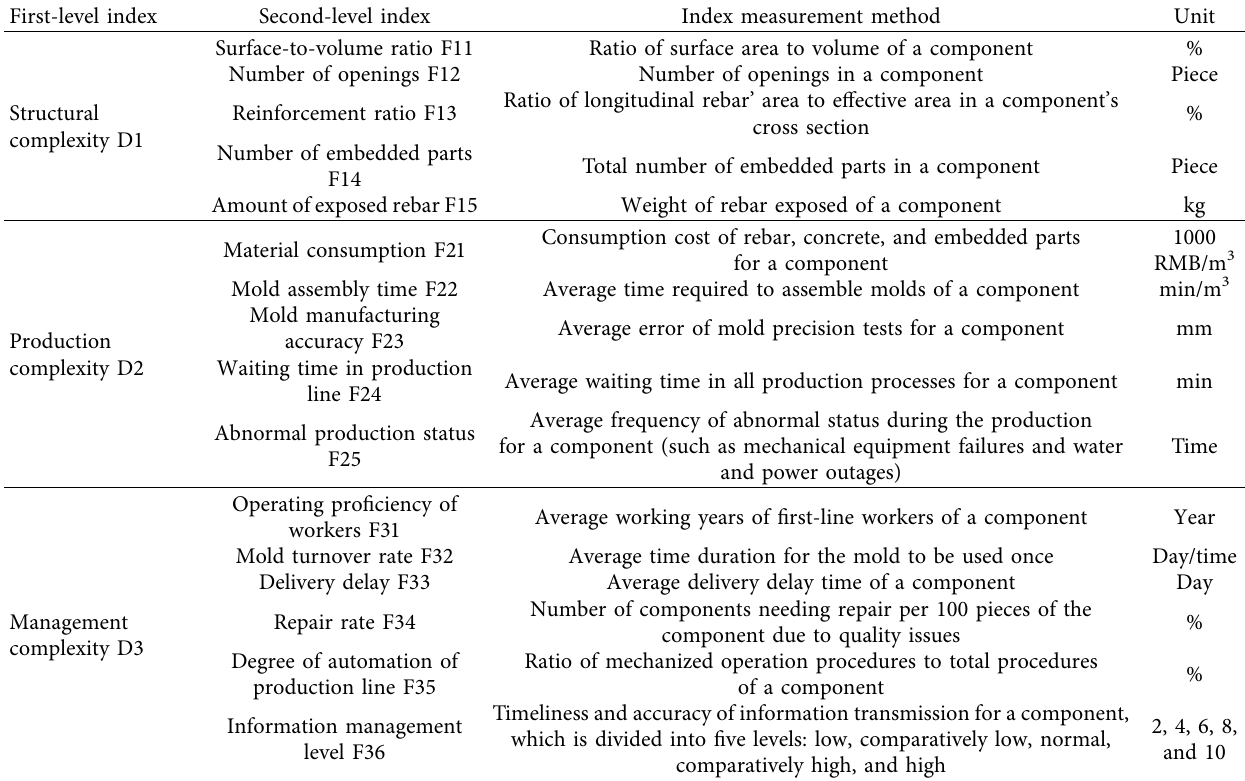
Table 6: Complexity index measurement of PC